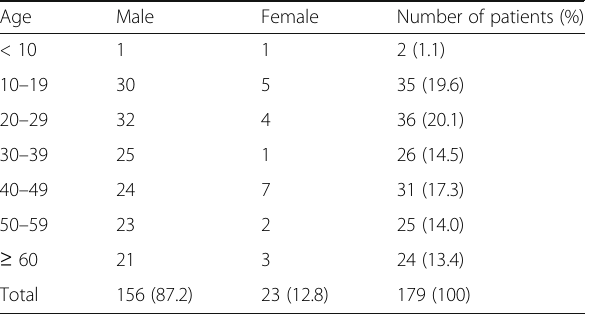
Table 2 Distribution according to age and gender